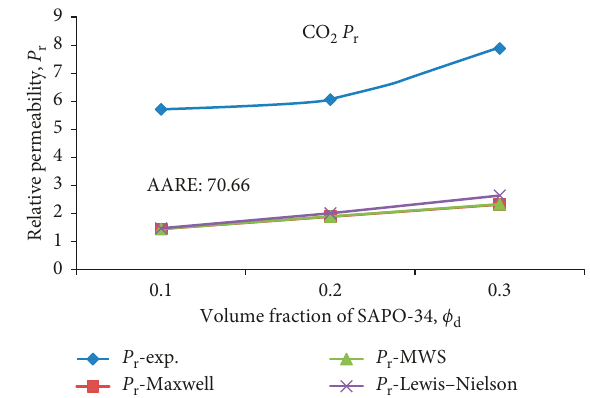
Figure 3: Relationships between experimental and theoretical relative permeability against SAPO-34 volume fraction at 20bar. Table 3: Deviation of model values from experimental data for CO relative permeability at 20 bar pressure (data from Table 2).